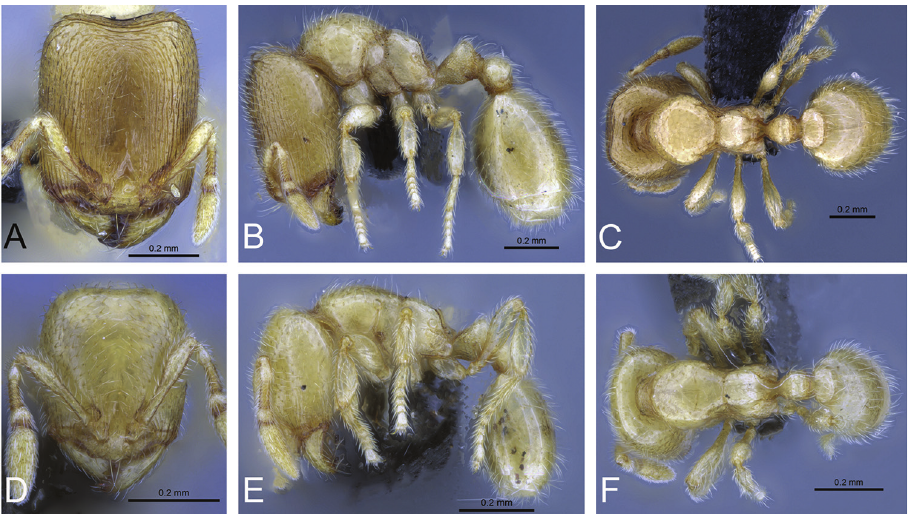
Figure 65. Carebara tanana –holotype. Major worker, CASENT0211683: A head in full-face view B body in profile view C body in dorsal view. Minor worker, CASENT0211714: D head in full-face view E body in profile view F body in dorsal